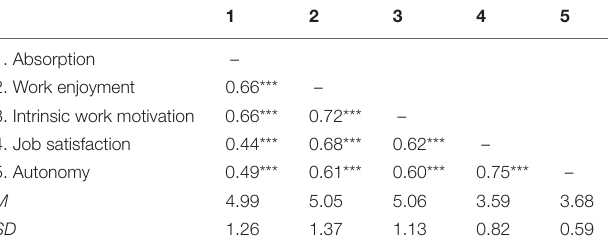
TABLE 1 | Means, standard deviations, and correlations of the study